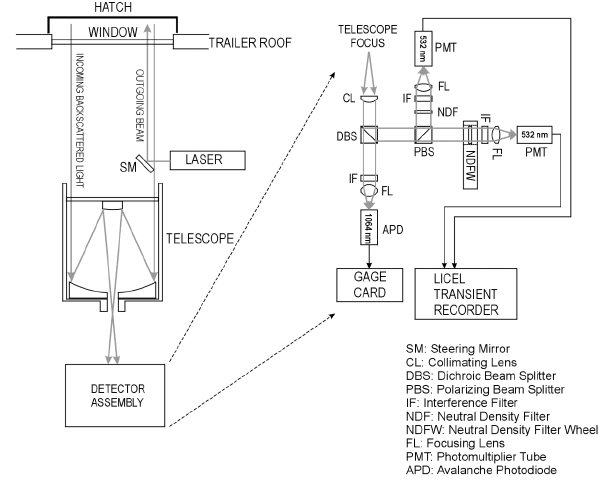
Fig. 2. A schematic showing the major components in the optical design of the lidar